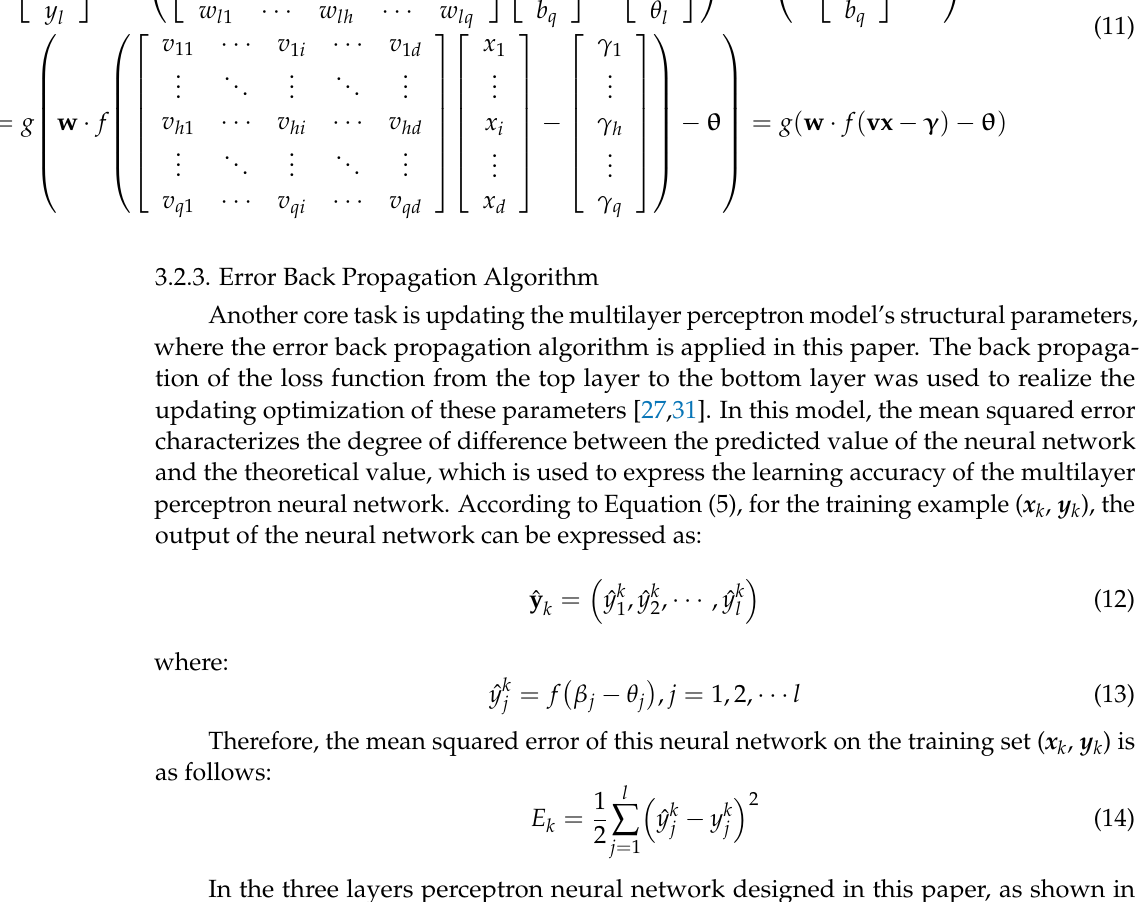
Figure 5, a total of (d + l + 1) × q + l network parameters need to be optimized: d × q weight values from the input layer to the hidden layer, q × l weight values from the hidden layer to the output layer, q thresholds of hidden layer neurons, and l thresholds of output layer